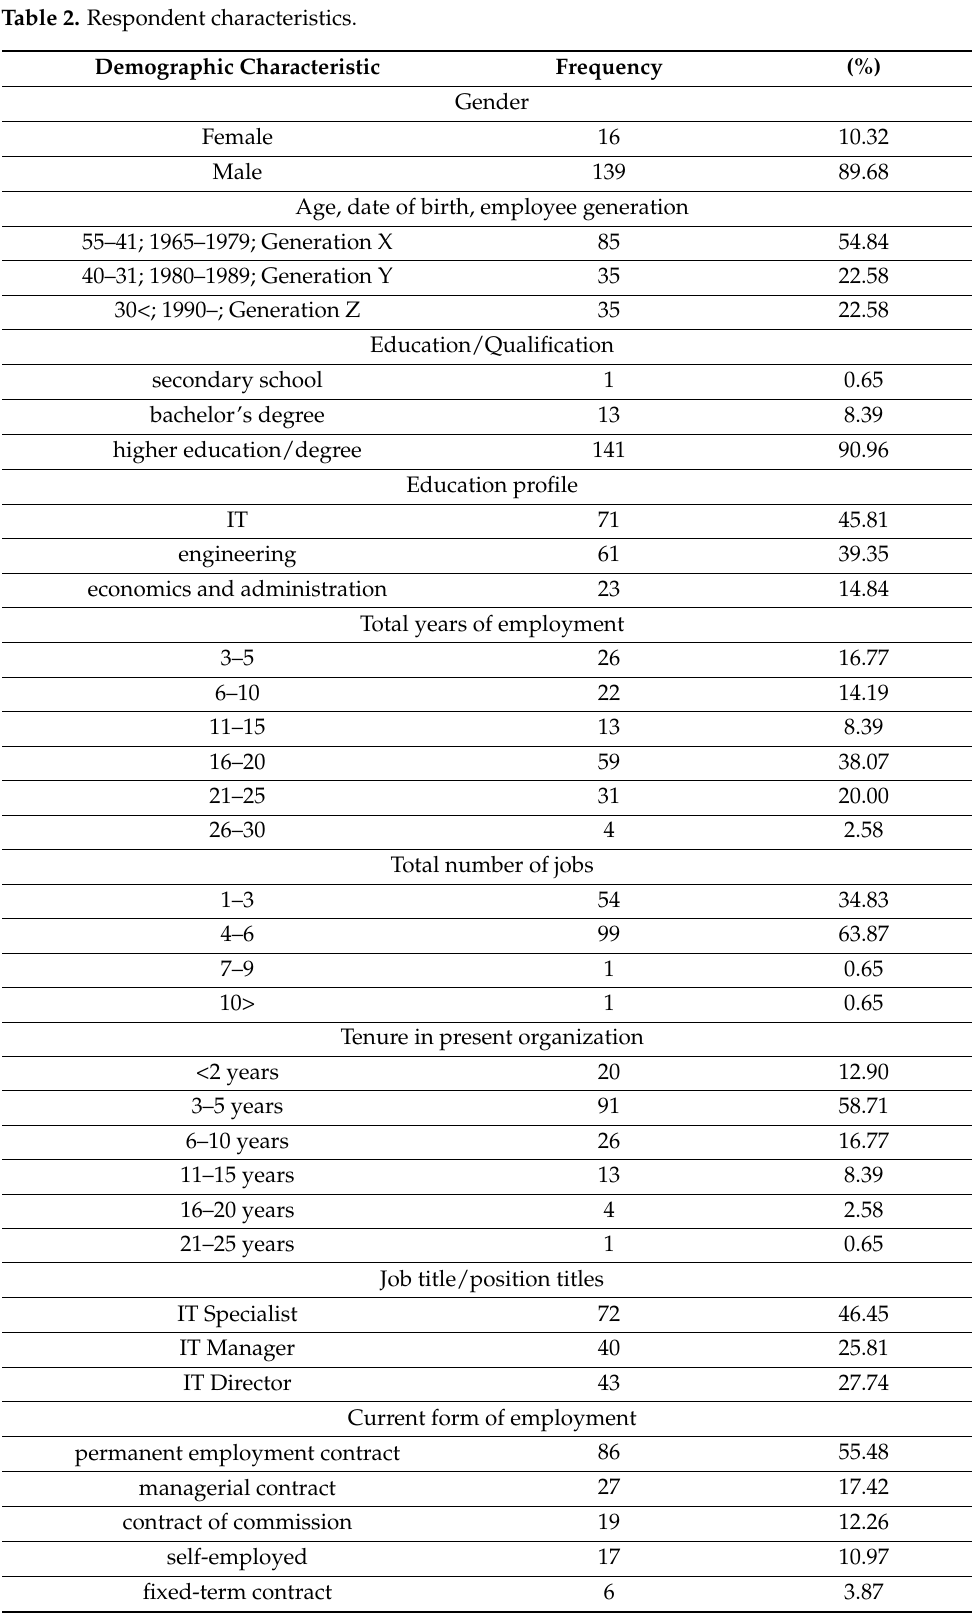
Table 2. Respondent